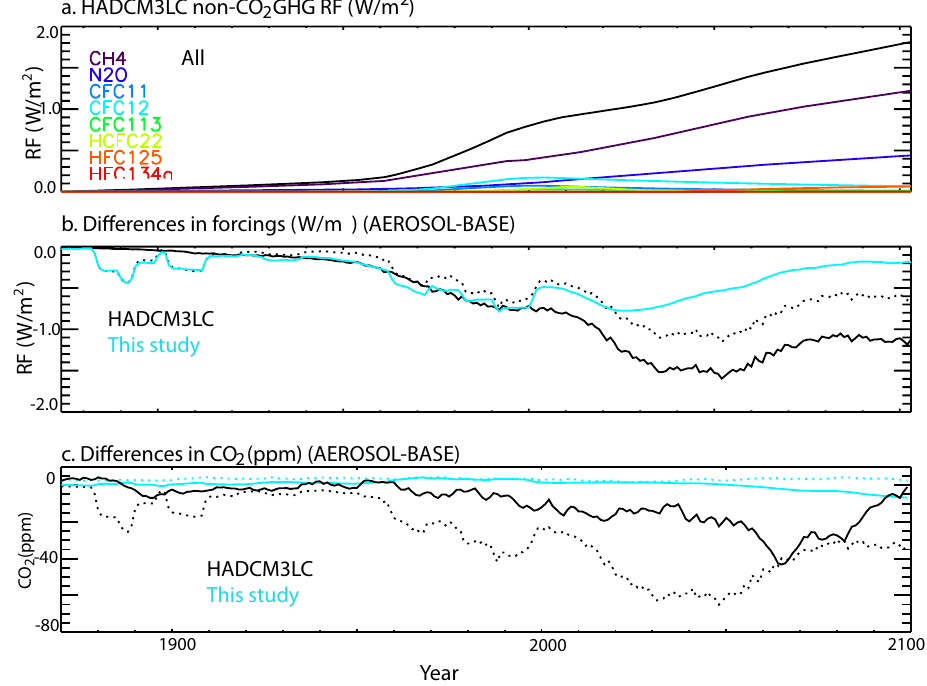
Fig. 7. Radiative forcing from non-CO 2 greenhouse gases for the HADCM3LC (Wm − 2 ) from all constituents (black) and from methane, ni- trous oxide, CFC11, CFC12, CFC113, HCFC22, HCFC125, HCFC134a (Wm − 2 ) (a) . Differences in radiative forcings from the AEROSOL- BASE case for this study (cyan) and for the HADCM3LC study (Jones et al., 2003 minus Cox et al., 2000) (b) . The black solid line rep- resents estimates for sulfate aerosols (direct and indirect), while the dotted black line includes the impact of troposphere ozone changes for the HADCM3LC. Carbon dioxide difference (ppm) between 1870 and 2100 for coupled-carbon-climate models with and without aerosols for the simulations here (cyan) and the HADCM3LC simulations (Jones et al., 2003 minus Cox et al., 2000) (c) . Solid lines are 3-d model results, dotted lines are estimates from the simple feedback model described in Sect. 2.3 including aerosol globally averaged